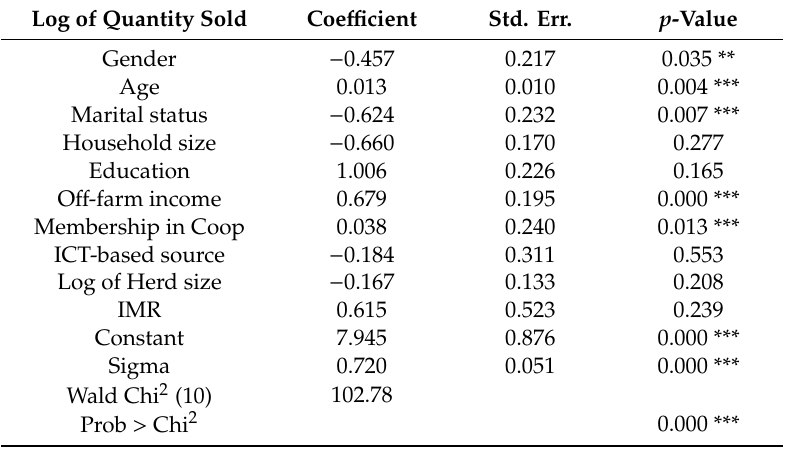
Table 5. Truncated model estimates: Intensity of market